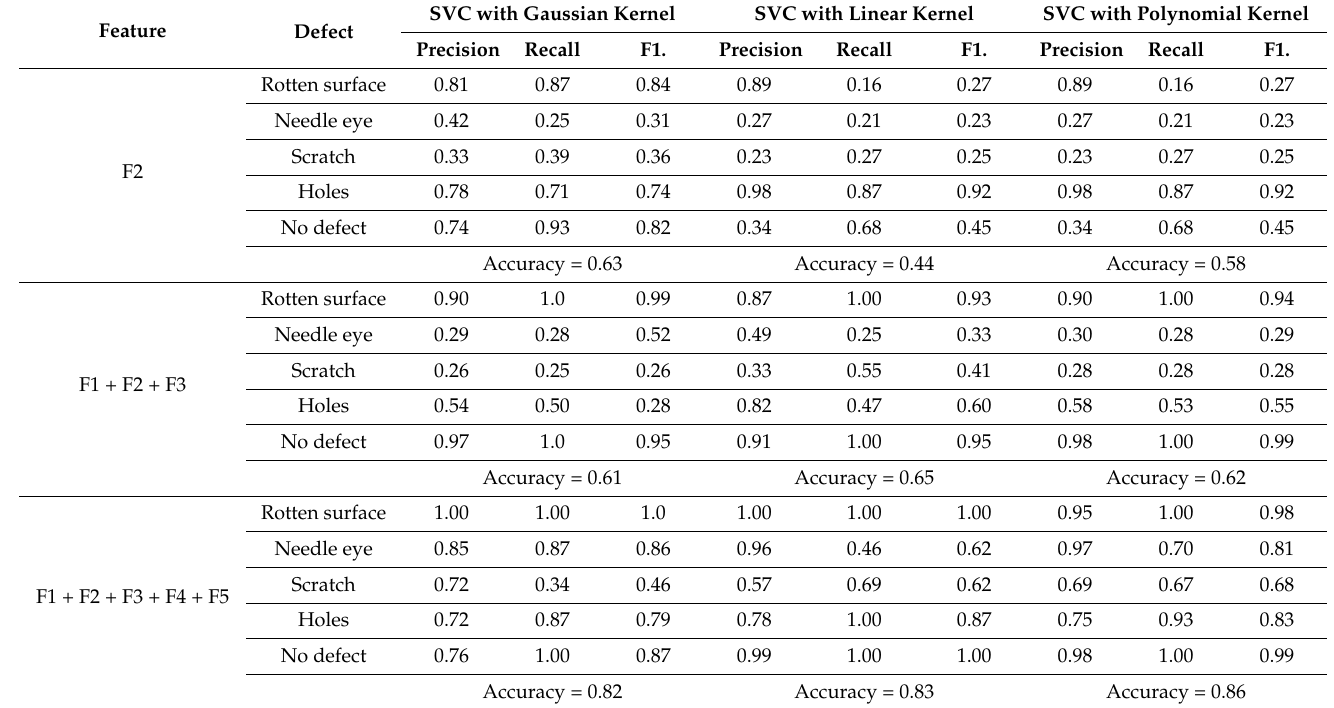
Table 7. SVM-based leather surface defect